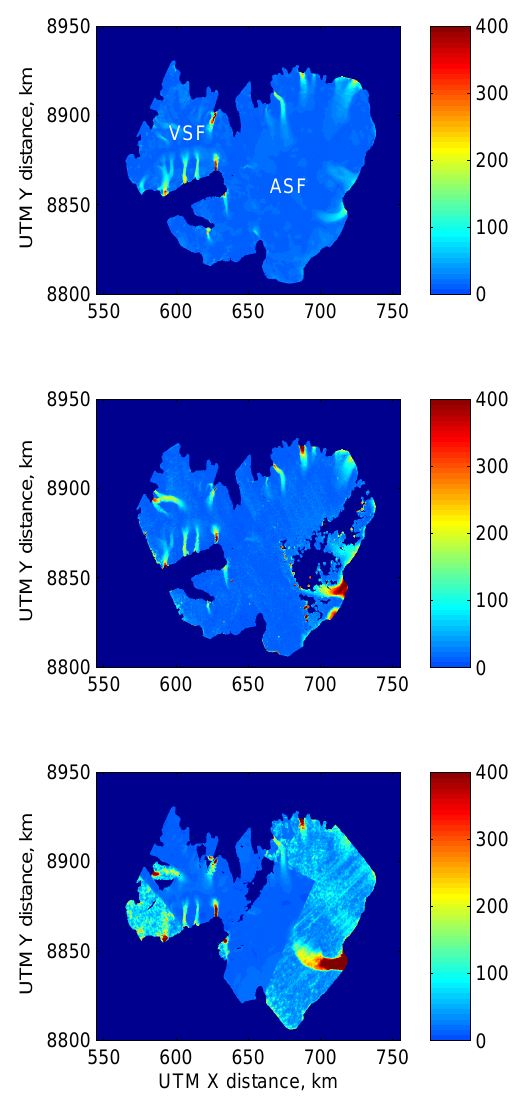
Figure 2. Observed winter velocity magnitude (in ma − 1 ) over Nor- Fig. 2. Observed winter velocity magnitude (in ma − 1 ) over Nor- daustlandet from 1995 (top), 2008 (middle) and 2011 (bottom). B3 daustlandet from 1995 (top), 2008 (middle) and 2011 (bottom). B3 is the most prominent outlet glacier on the eastern side. Dark blue is the most prominent outlet glacier on the eastern side. Dark blue indicates no data. UTM zone is 33N. Neighbouring ice cap Vestfona indicates no data. UTM zone is 33N. Neighbouring ice cap Vestfona (VSF) is also (VSF) is also shown.